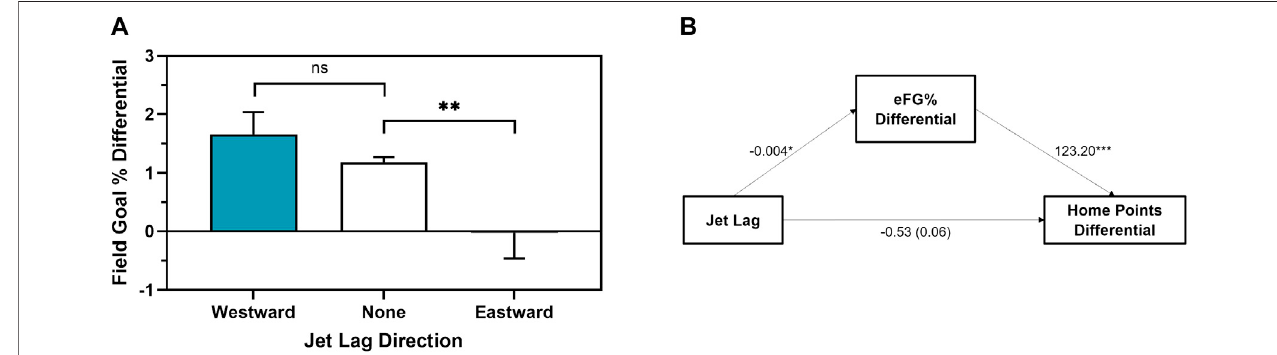
FIGURE 5 | (A) represents raw means based on the association between directional jet lag (blue = westward, white = none (reference), orange = eastward) and hometeameffective fi eldgoalpercentage(eFG%)differential. (B) representsthemediationalmodelandregressioncoef fi cientsfortherelationshipbetweendirectionaljet lagandhomepointsdifferentialasmediatedbyhomeeFG%differential.Theregressioncoef fi cientbetweenjetlagandhomepointsdifferential,controllingforhomeeFG % differential, is in parentheses. ns = not signi fi cant, p > 0.10, * p < 0.05, ** p < 0.01, *** p <